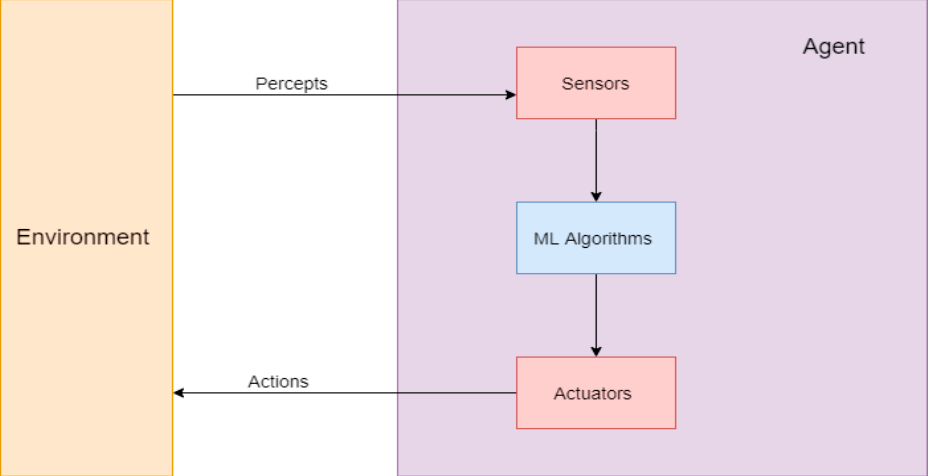
Figure 3. Components of an AI system. Data from the environment is inputted into the AI agent through sensors. This data is transformed/analyzed by ML algorithms that then instruct actuators to conduct certain actions on the environment.